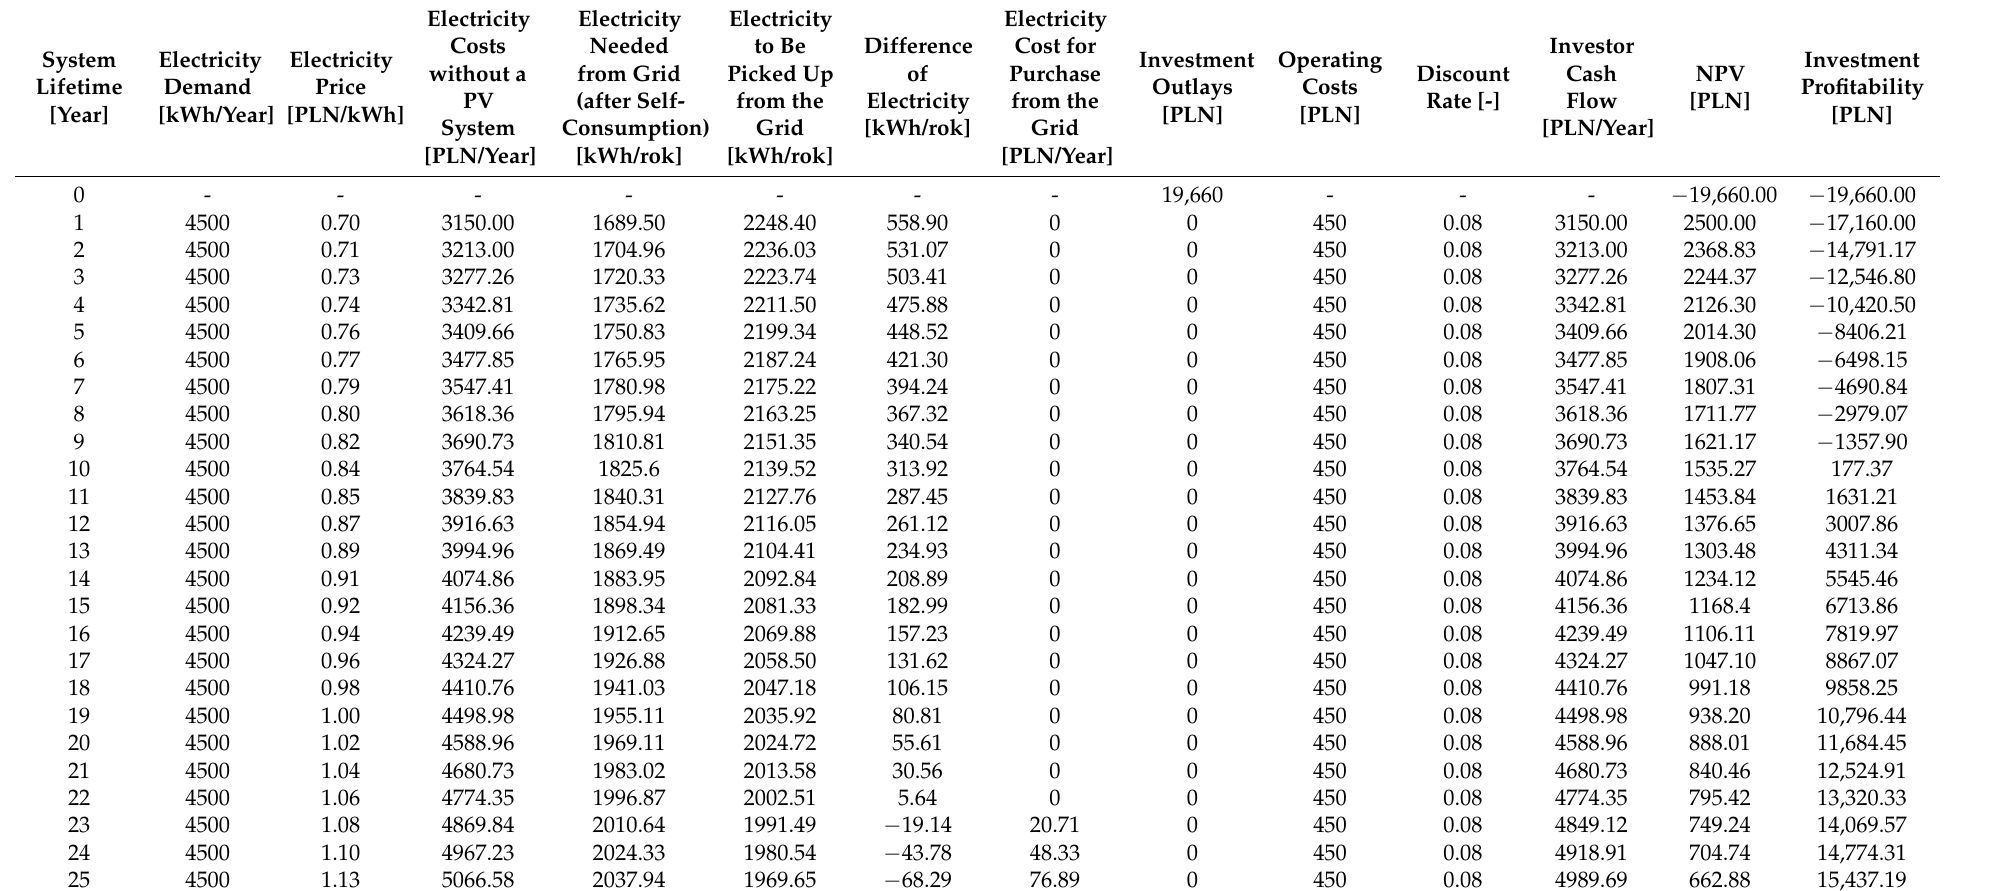
Table A4. NPV results of the PV installation for the discount system, at a 50% self-consumption